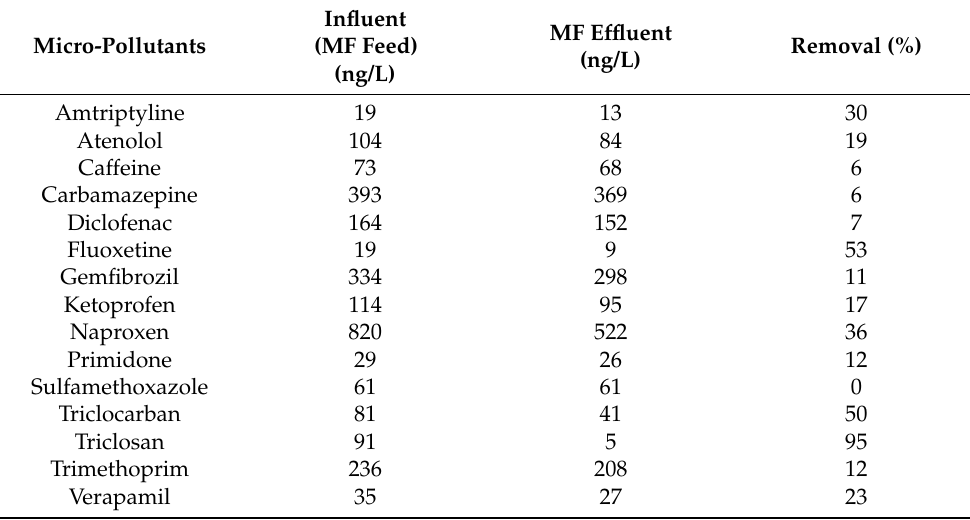
Table 2. Removal (%) of micro-pollutants by MF filtration of 0.2 µ m pore